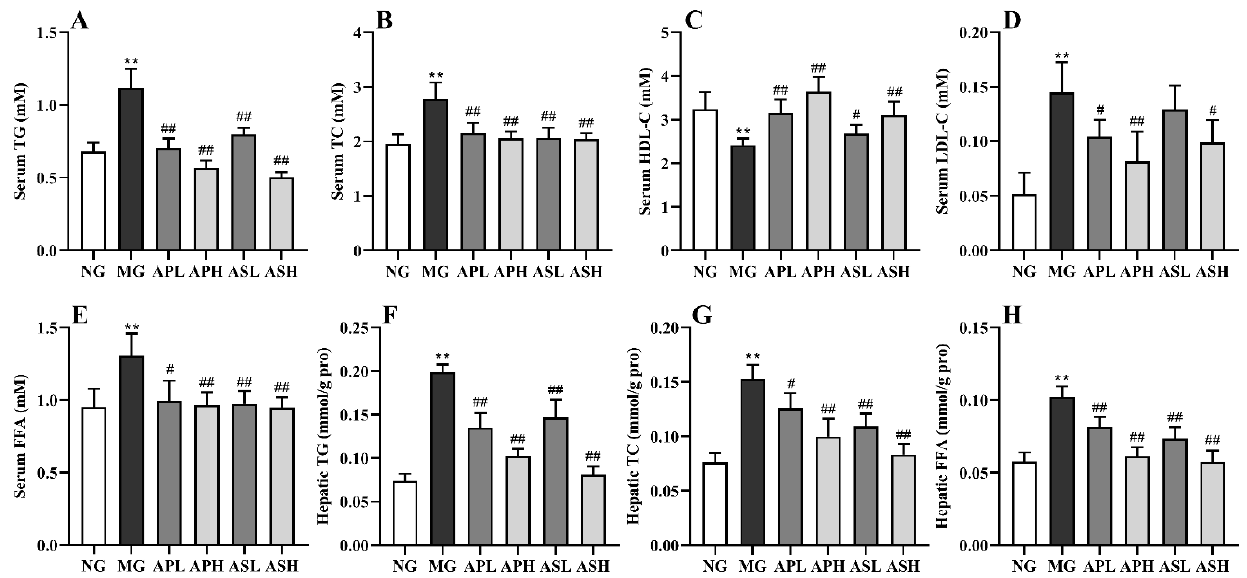
Figure 2. Effect of AP and AS on the serum and liver lipids in ALD mice. ( A ) Serum TG; ( B ) Serum TC; ( C ) Serum HDL-C; ( D ) Serum LDL-C; ( E ) Serum FFA; ( F ) Hepatic TG; ( G ) Hepatic TC; ( H ) Hepatic FFA. Data are expressed as mean ± SD ( n = 12). ** p < 0.01, vs. NG; # p < 0.05, ## p < 0.01, vs. MG.